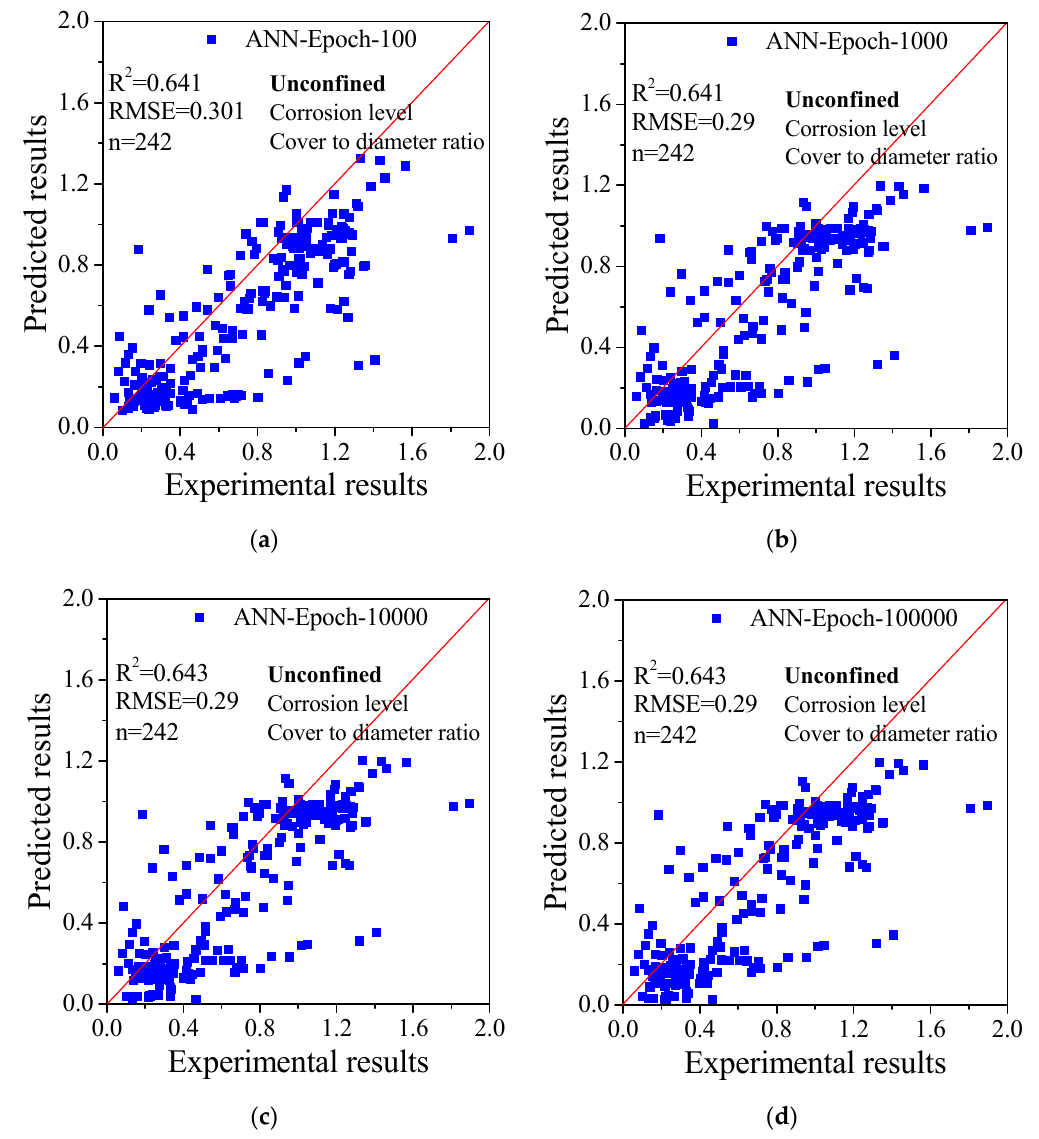
Figure 4. Comparison of the results predicted by ANN using different epochs: ( a ) 100; ( b ) 1000; ( c ) 10,000; and ( d ) 100,000.